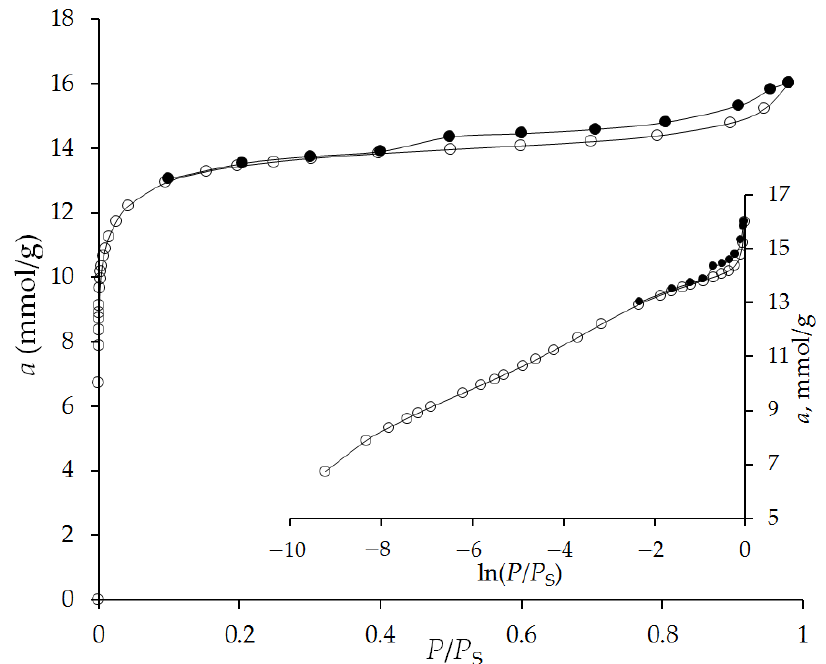
Figure 5. Adsorption (light symbols) and desorption (solid symbols) isotherms of nitrogen on the microporous carbon adsorbent ACPK at 77 K in linear and semi-logarithmic coordinates. Lines – spline approximation.